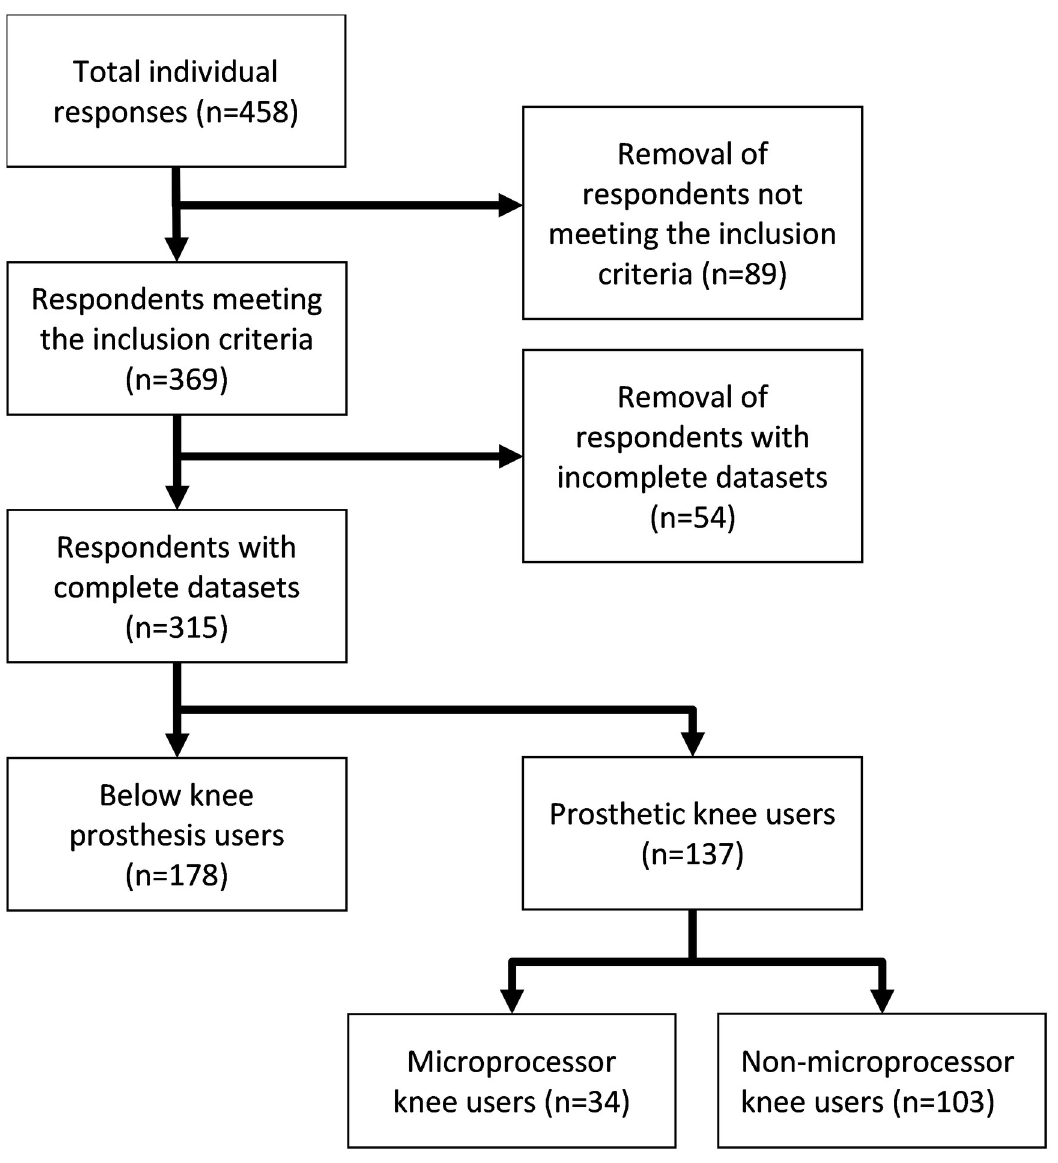
Fig 1. Flowchart showing the breakdown of the study